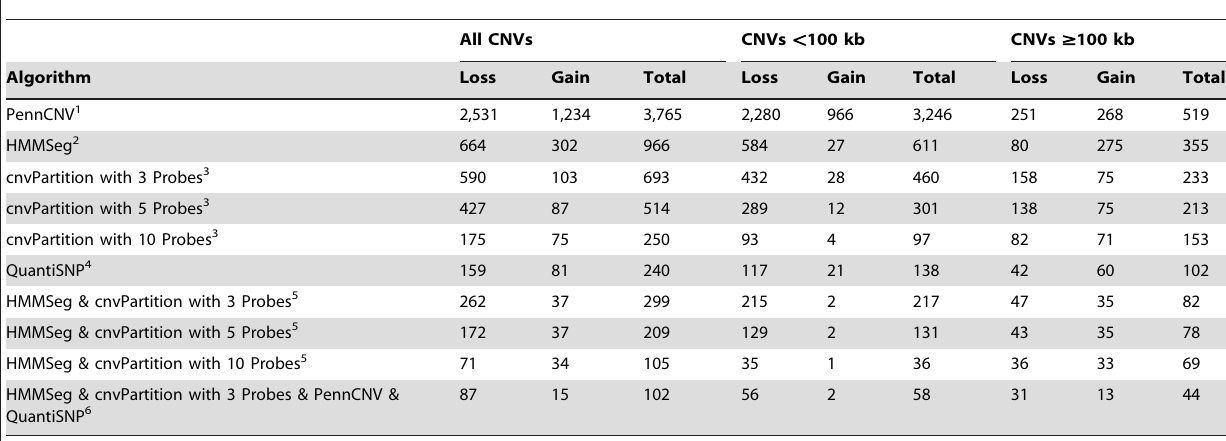
Table 2. Number of CNVs detected in 96 subjects by each algorithm.